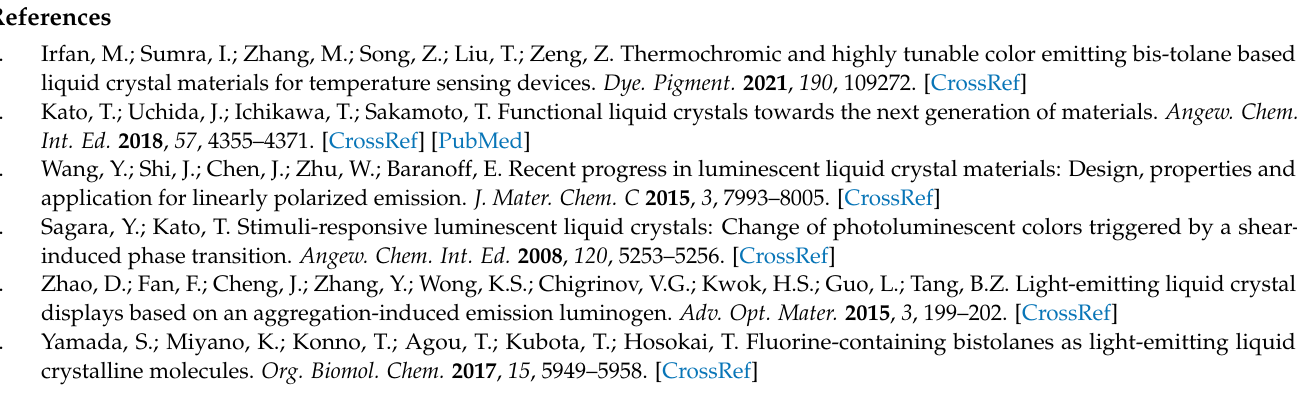
Table S1: Crystallographic data of 1a and 1e ; Table S2: Phase transition behaviors of 1a – h observed by DSC measurements; Table S3: Solvent effect on the photophysical behavior; Tables S4 and S5: Cartesian coordinate for 1a and 1e